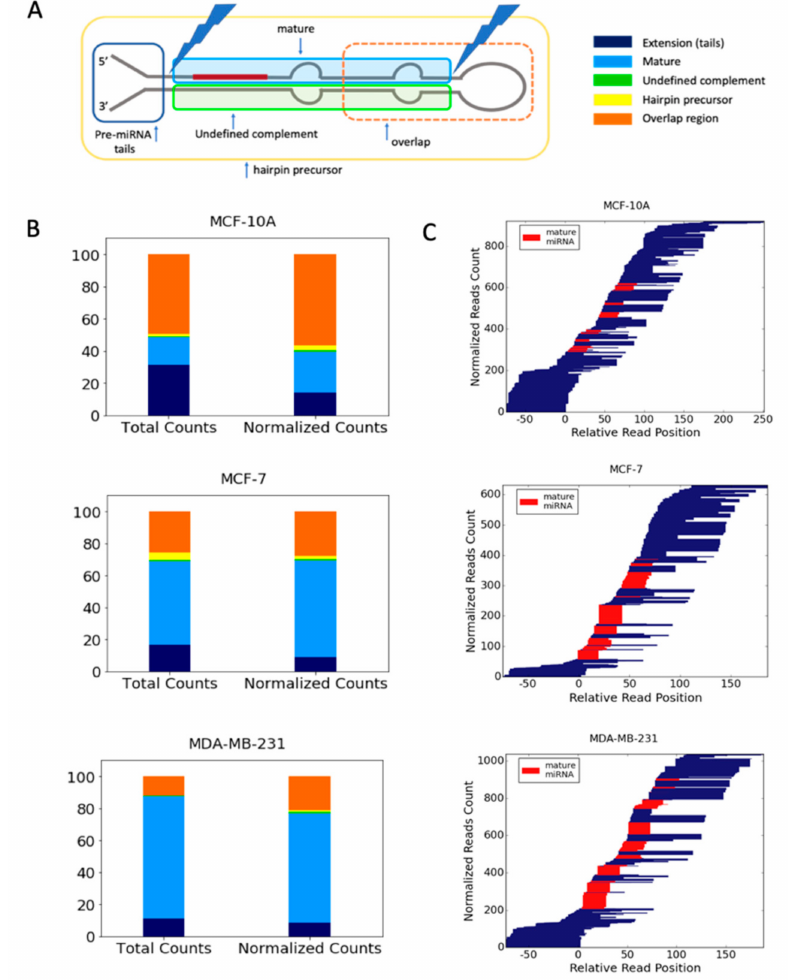
Figure 4. Partition of the SF-miRNAs to segmental pre-miRNA regions. ( A ) A schematic view of an miRNA prototype, where the di ff erent regions of the HP-miRNA are listed according to their positions with respect to the pre-miRNA major processing sites. An example for an overlap region, defined as reads that cross known segmental boarders, is indicated. ( B ) The relative counts of reads mapped to each of the predefined regions for each of the three cell lines. The relative counts of reads to each of the pre-miRNA regions are color-coded as in A. Total counts of reads (left) and normalized counts (right, the relative abundance of reads aligned to a specific miRNA sums to 1) by each miRNA are shown for MCF-10A, MCF-7, and MDA-MB-231. ( C ) Blocks of reads from the same starting points reflect non-randomized cleavage sites. The 5p and 3p mature miRNAs are colored red, and the width of the bars is proportional to the number of reads. The position and alignment of the mature miRNAs is according to the miRbase annotations. All miRNAs that are analyzed have an average minimal number of reads per cell-line ( ≥ 3), and a minimal read length of ≥ 17. Data source is in Supplemental Table